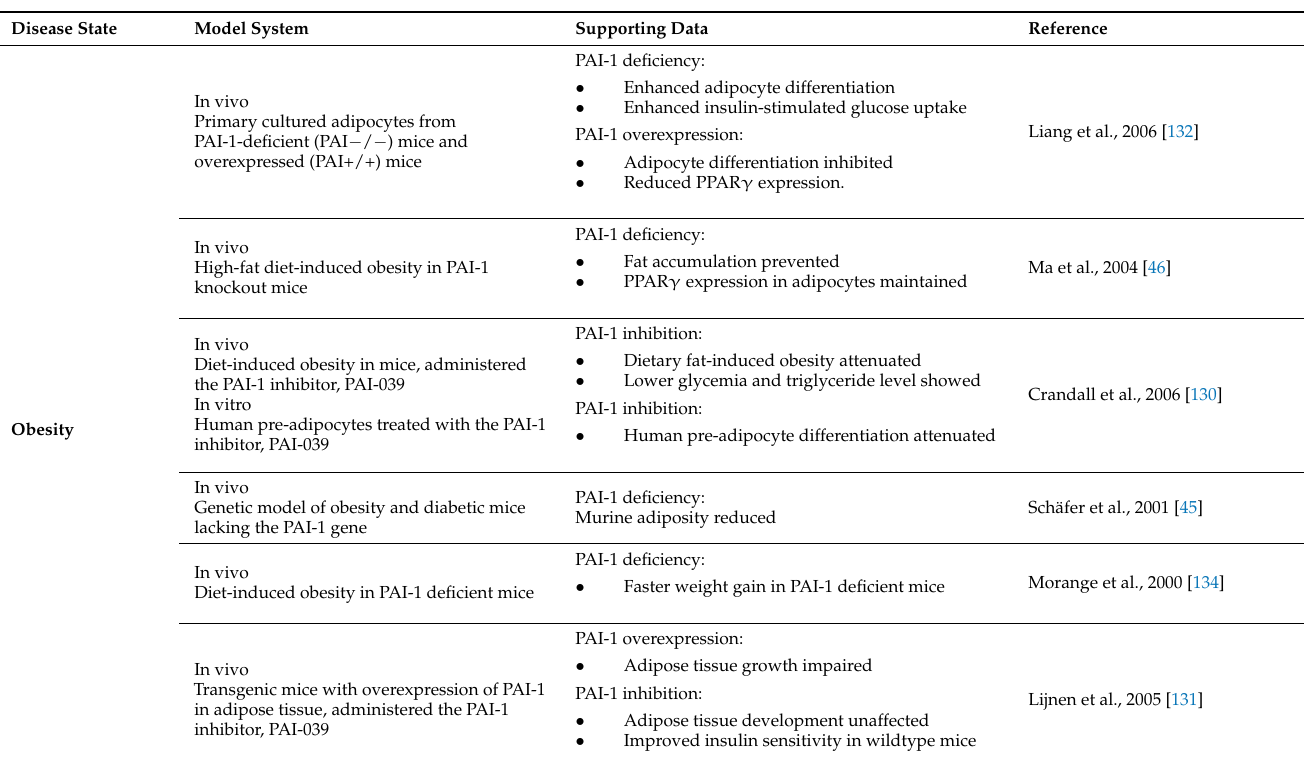
Table 1. Studies supporting the role of PAI-1 in the development of obesity, insulin resistance, and type-2